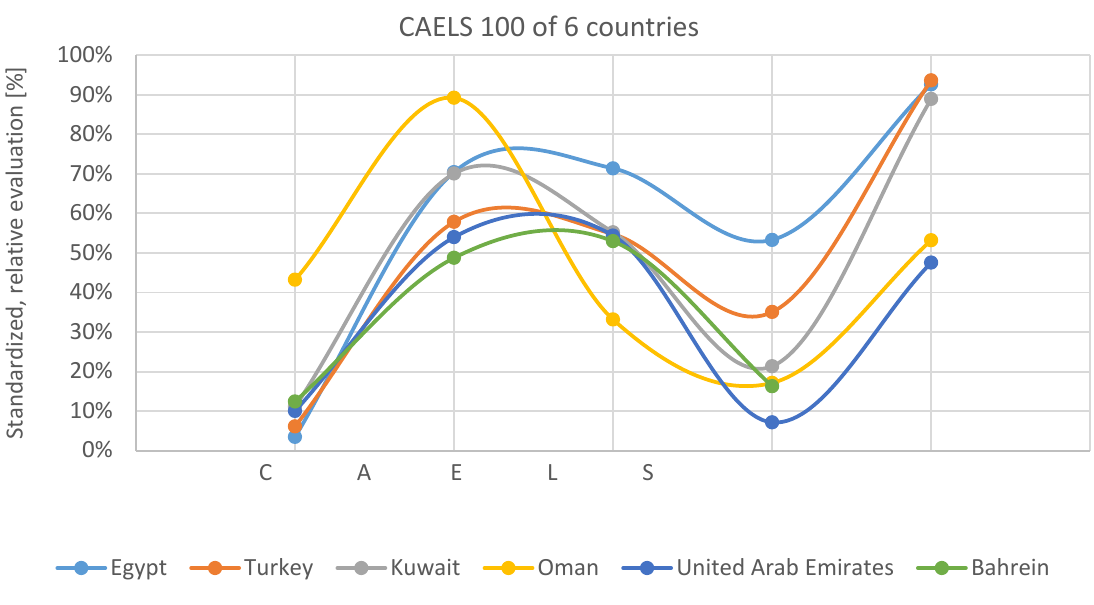
Figure 2. CAELS 100 results for the six countries investigated for the period